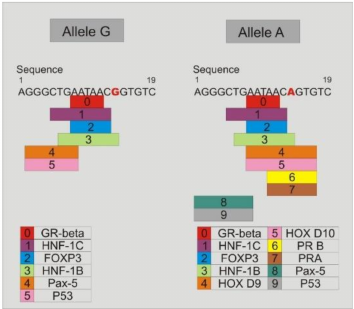
Figure 5. Study of the transcription factor binding sites in the DNA sequence where the TLR4 -rs2737190 is located. The transcription factor HNF-1B binds in the presence of the allele TLR4 -rs2737190-G. When the allele A is present, five more transcription factors bind to the site: HOX D9, HOX D10, and progesterone receptors PR-B and